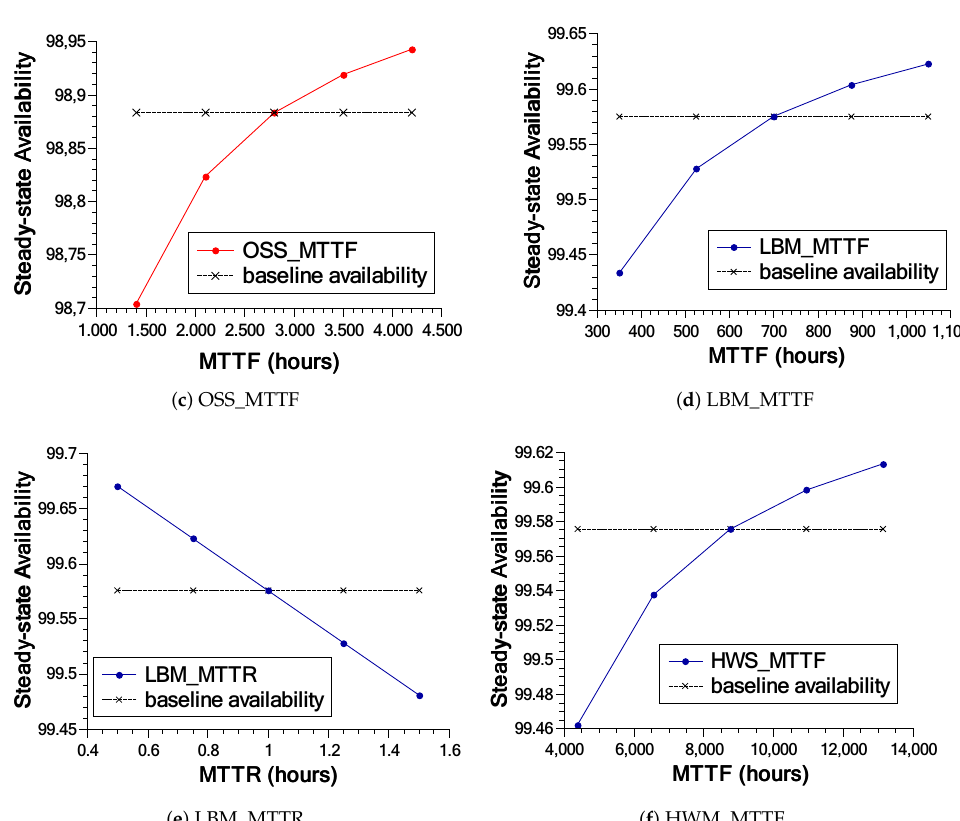
Figure 17. Results ( a – c ) show the three most important transitions in the base model; Re- sults ( d – f ) present the results of the sensitivity analysis of the most important transitions in the extended